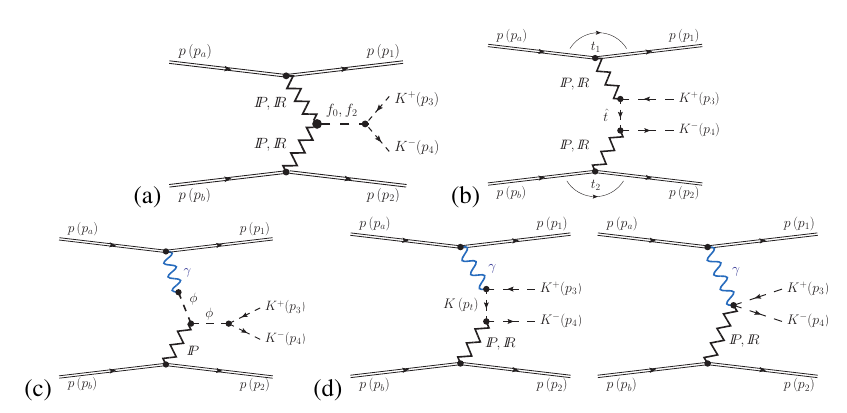
Figure 1. Schematic Born-level diagrams of: (a) central exclusive purely di ff ractive scalar and tensor resonance and (b) continuum K + K − production, (c) φ resonance and (d) non-resonant photoproduction. amplitude is a coherent sum of continuum amplitudes and the amplitudes with the s -channel scalar ( f 0 (980), f 0 (1500), f 0 (1710)) and tensor ( f 2 (1270), f (cid:48) (1525)) resonances. 2 For instance, the Born (without absorption e ff ects) amplitude for the process pp → pp ( IPIP → f (cid:48) (1525) → K + K − ) within the tensor-pomeron model can be written 2